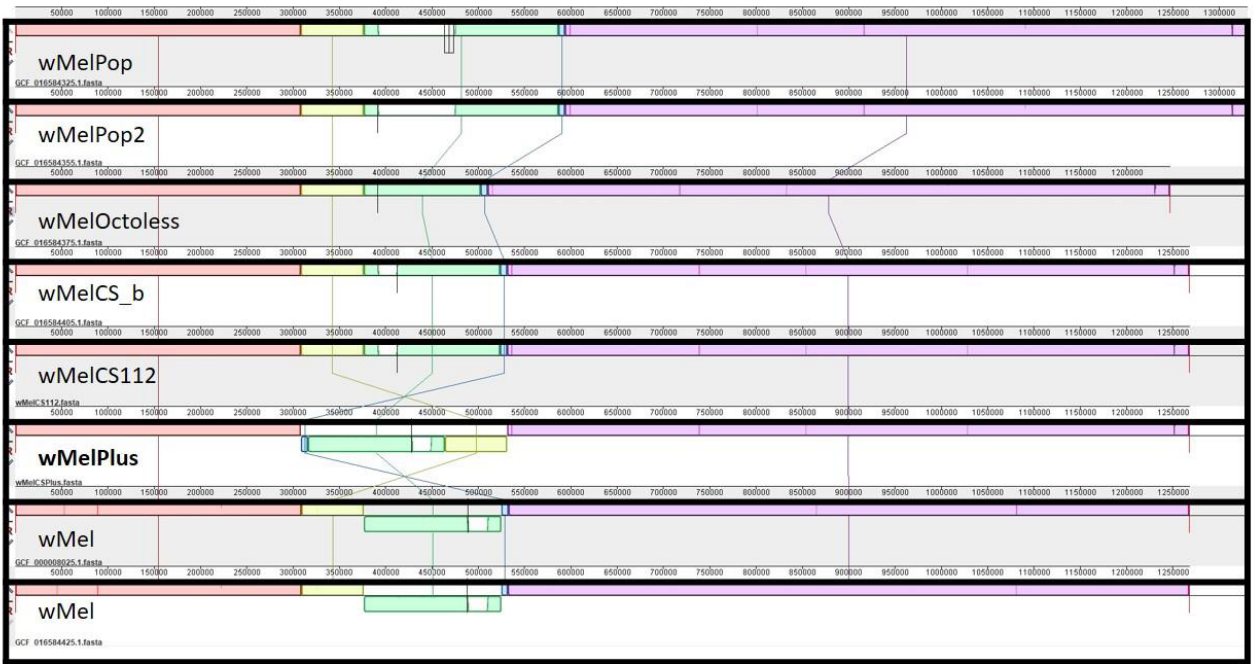
Figure 1. The inversion map resulting from the comparative genomic analysis of wMel and wMelCS groups of Wolbachia pipientis strains. Different colors represent homologous sequence blocks. Dis- continuous joints of blocks depict the inversion breakpoints. White blocks represent Octomom, which is absent in the wMelOctoless strain [37]. These are the coordinates of the homologous se- quence blocks in the wMelPlus genome: (1 … 308,920) — red, (308,921 … 316,275) — blue, (316,276 … 463922) — green, (463,923 … 531,364) — yellow.